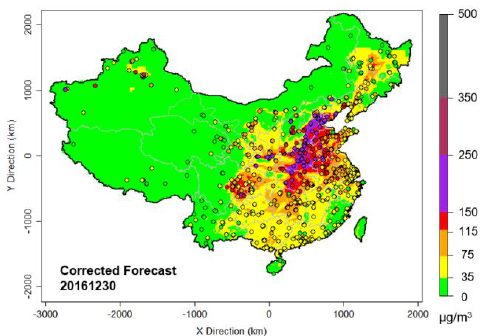
Figure 6. Bias-corrected CMAQ PM 2.5 forecast over China for 30 December 2016 (5-day lead time) by the CART-LM-KF-AN method. The dots represent observed PM 2.5 levels.